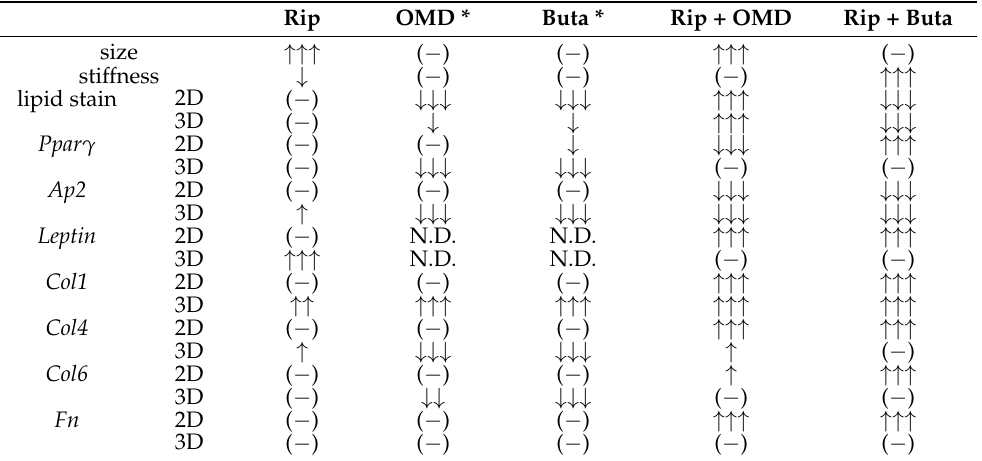
Figure 6. Additive effects of EP2 agonists to ripasudil (Rip) on the mRNA expression of ECMs in 3T3-L1 3D organoids. The 3D organoids of 3T3-L1 cells were prepared under several sets of conditions: preadipocytes of 3T3-L1 cells (DIF-) or adipogenic differentiation (DIF+) with or without the combination of 10 µ M ripasudil (Rip) and the EP2 agonist, 100 nM omidenepag (OMD) or 100 nM butaprost (Buta). The specimens collected at Day 7 were subjected to a qPCR analysis to estimate the expression of mRNA for the ECMs ( Col1 : collagen 1; Col4 : collagen 4; Col6 : collagen 6; Fn : fibronectin). All experiments were performed in duplicate using fresh preparations, each of which consisted of 16 organoids. Data are presented as the arithmetic mean ± the standard error of the mean (SEM). * p < 0.05, ** p < 0.01, **** p < 0.001 (ANOVA followed by a Tukey’s multiple comparison test). Table 1. Summary of effects of single or combinations of Rip and EP2 agonists on the physical properties of the 3D 3T3-L1 organoids and adipogenesis and gene expressions of 2D and 3D cultured 3T3-L1